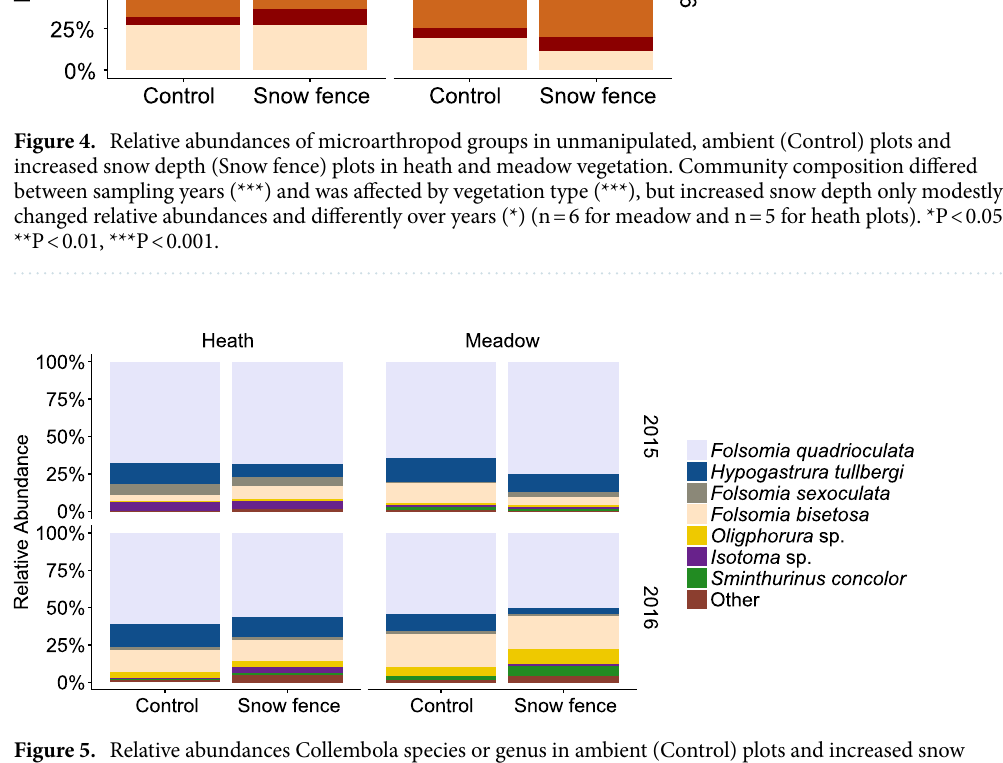
Figure 5. Relative abundances Collembola species or genus in ambient (Control) plots and increased snow depth (Snow fence) plots in heath and meadow vegetation. Collembola species relative abundance differed between years (***) vegetation types (***), and these interacted (**). Snow fence effects were modest, and differed over years (*) (n = 6 for meadow and n = 5 for heath plots). *P < 0.05, **P < 0.01, ***P < 0.001.